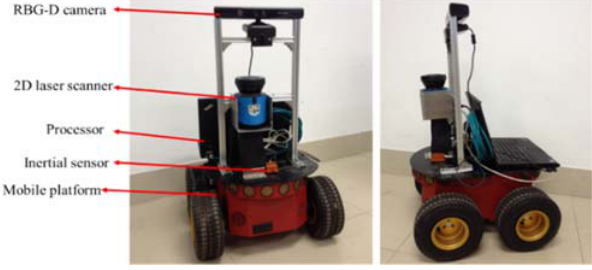
Figure 1. Mobile mapping system design